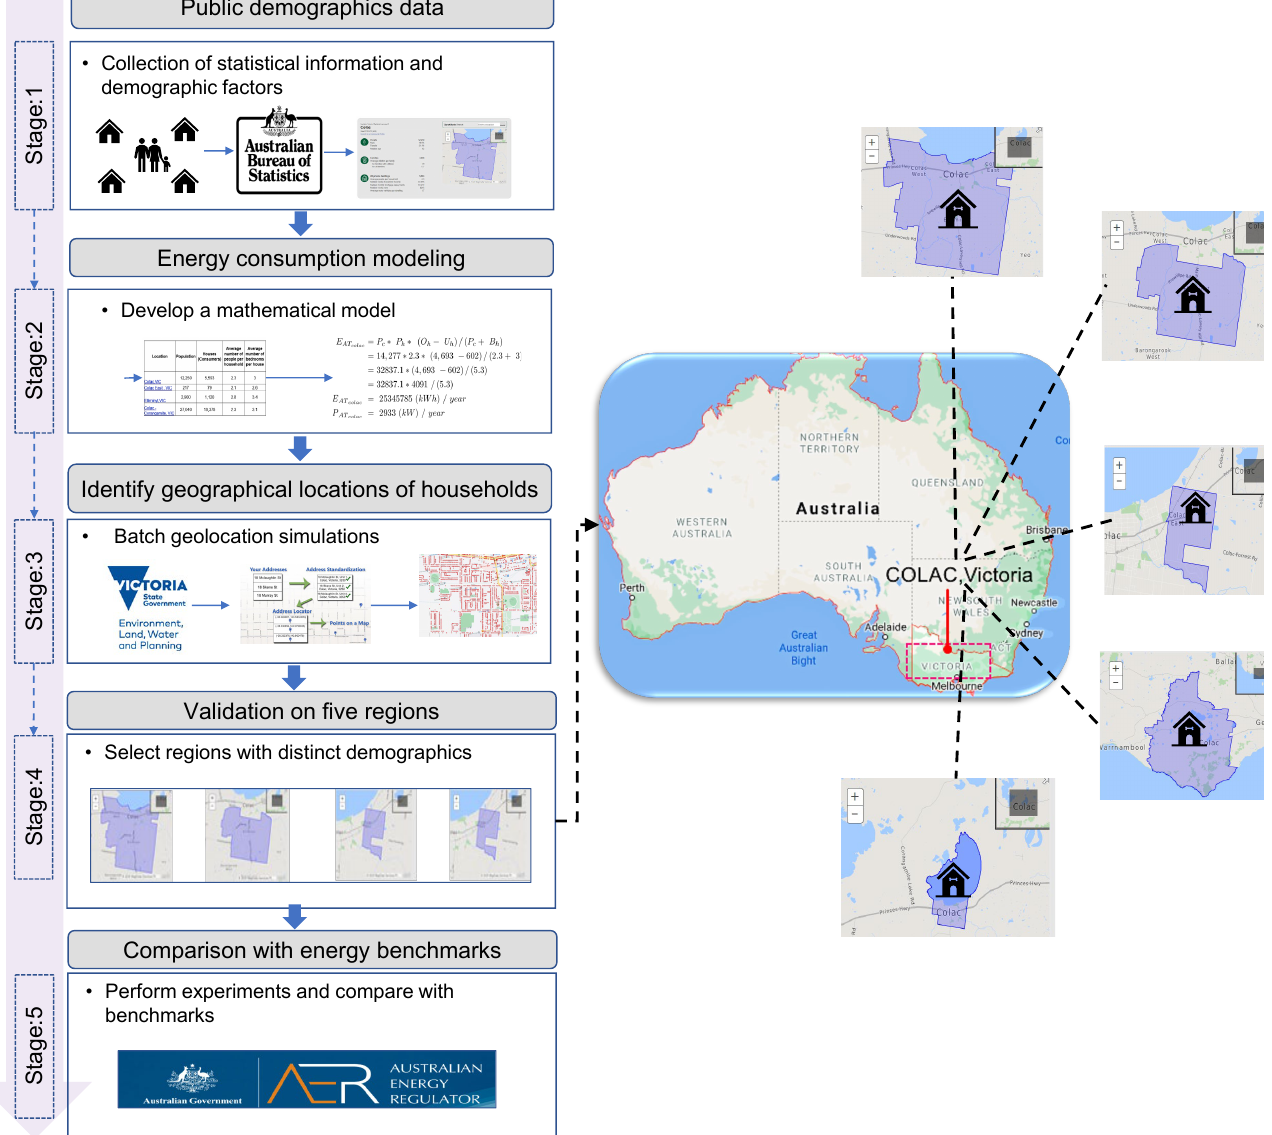
Figure 1. Framework of the proposed